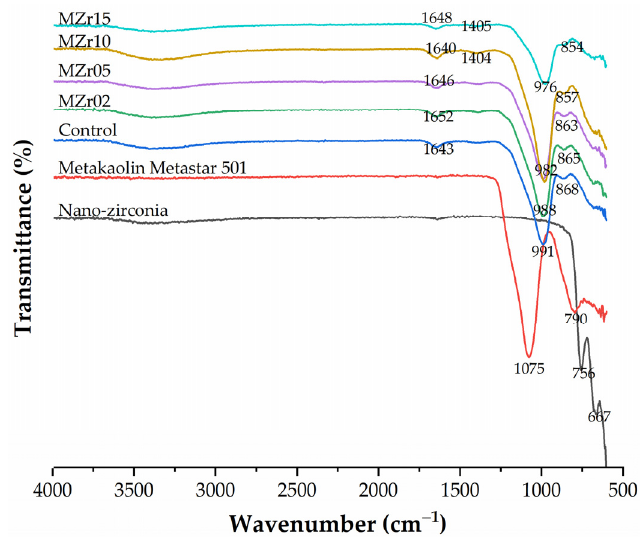
Figure 3. The FTIR spectra of starting materials and geopolymer samples.